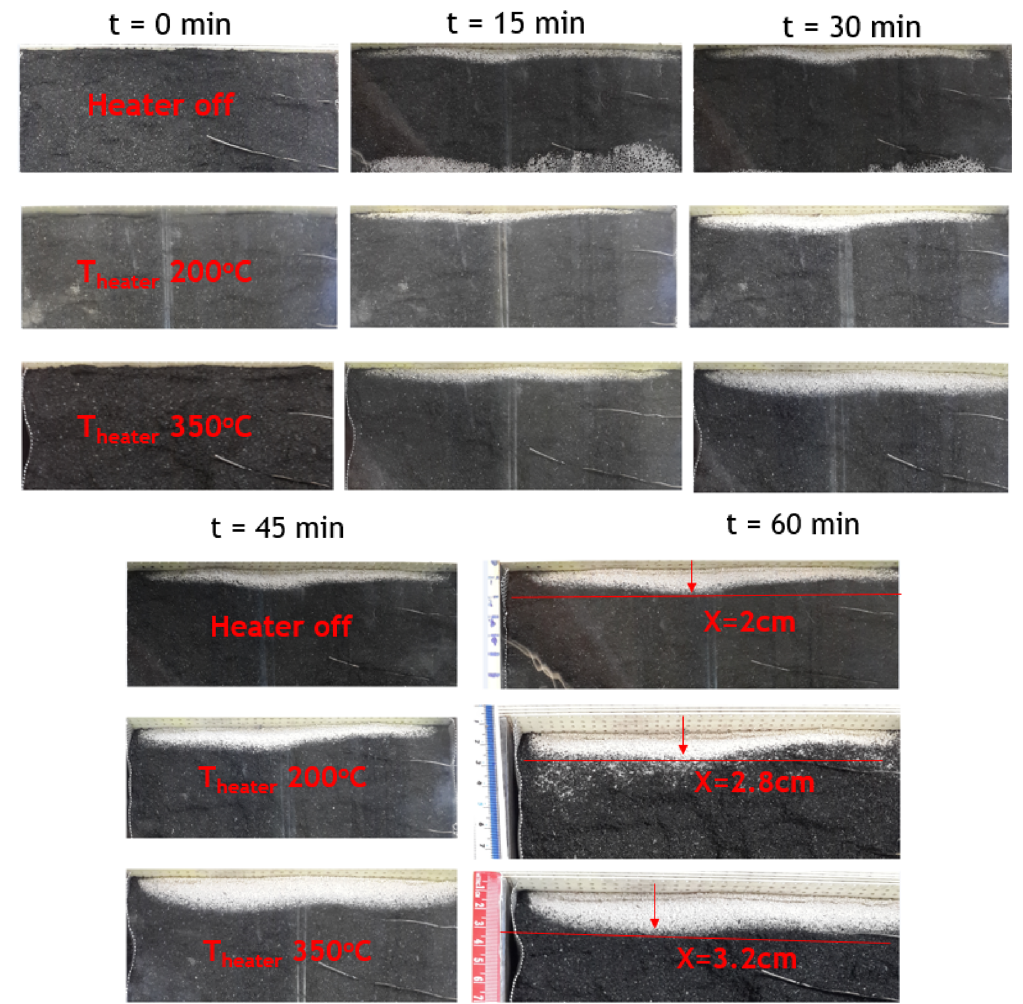
Fig. 11 Reaction front propagation of surface coal packed bed for coal